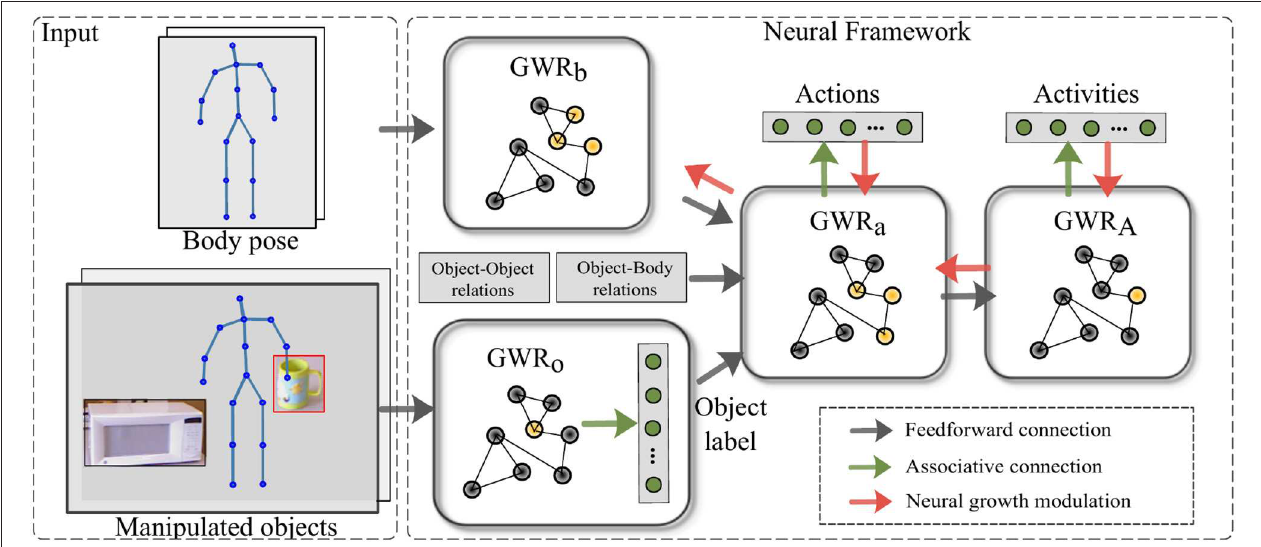
FIGURE 2 | Overview of the proposed architecture (Mici, 2018). The GWR b and GWR o networks process low-level features extracted from the skeletal body representation and the RGB images of the manipulated objects, respectively. Additional visual features are extracted to capture the body-object and object-object spatial relationships. The GWR a and GWR A networks learn spatiotemporal dependencies of the human-object interactions over two different time windows. Both networks have associative connections to two symbolic layers holding information about actions and activities. The top-down modulation mechanism, when enabled, modulates the learning of the GWR b , GWR a , and GWR A